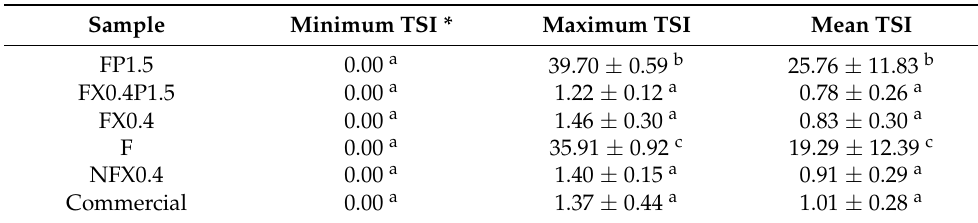
Table 10. Minimum, maximum, and mean values TSI for each sample. Means values not connected by same letters are significantly different.